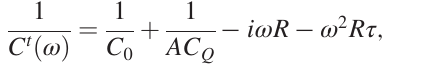
FIG. 3. (a) Charge fluctuations force versus distance between ribbon of width 0 . 1 μ m and area 1 μ m 2 and a metal plate at room temperature, where C t ð ω Þ is used. Typical values for τ and R are taken. (b) The normalized by fluctuations force as a function of the wire resistance for different relaxa- tion